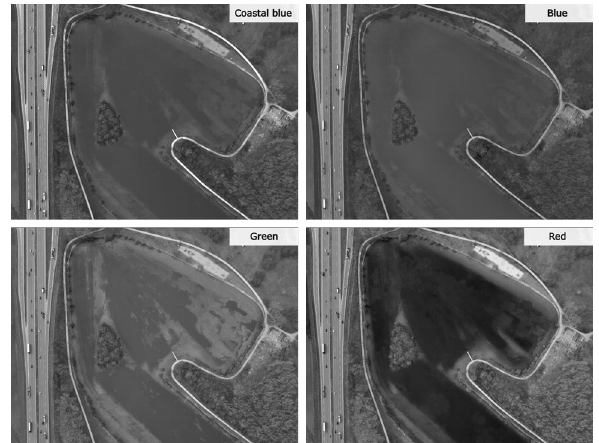
Figure 9. Color channels of aerial image 52922